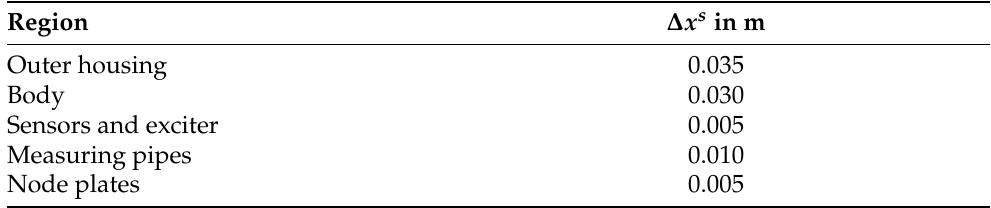
Table 2. Averaged characteristic length scales of the finite element mesh